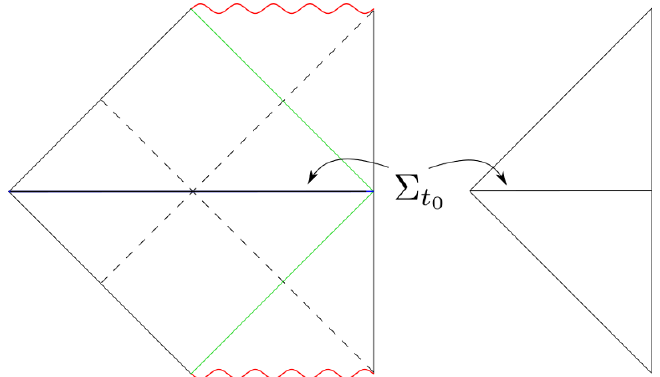
Figure 10 . The geometry on these slices is identical implying a natural identi(cid:12)cation of points between them. However, the proper distances from these points to the boundary di(cid:11)ers across the two cases because of the shockwave encountered near the